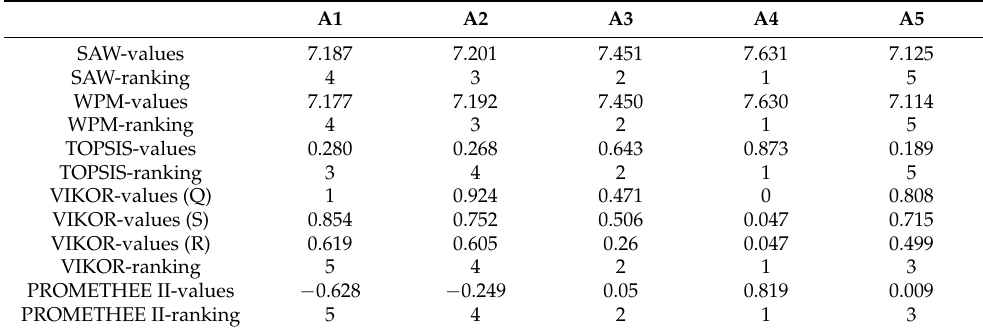
Table 7. Values and ranking of the alternatives based on SAW, WPM, TOPSIS, VIKOR, and PROMETHEE II.